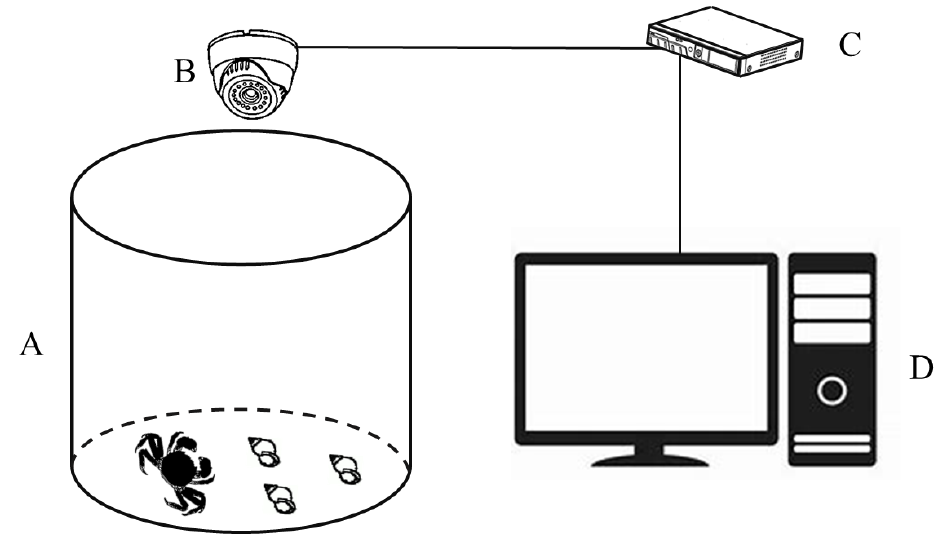
Figure 1. Video camera recording analysis system and round experimental aquarium: ( A ) experimental aquarium, ( B ) camera, ( C ) network video recorder, and ( D ) monitor.